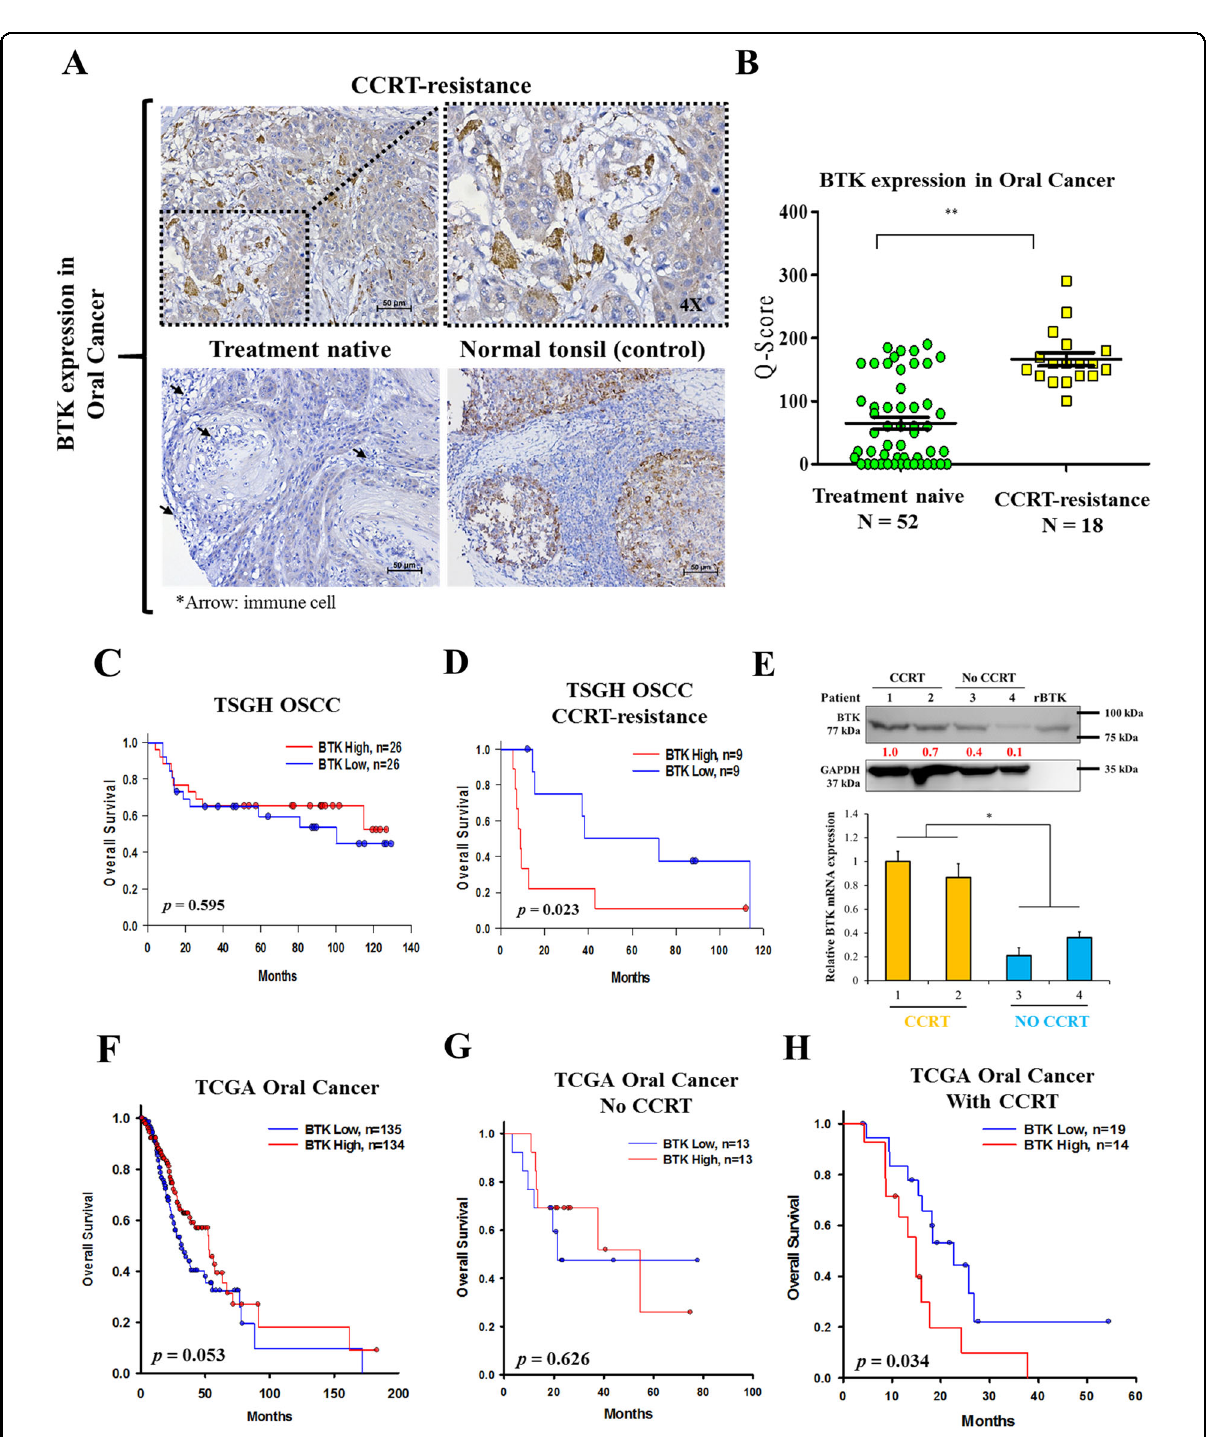
Fig. 1 BTK is aberrantly expressed in human OSCC tissues after additional treatment and in fl uences the survival rate. A IHC staining of BTK expression on OSCC tissues in CCRT-resistant (upper) and treatment-naïve tissue, normal tonsil as a control (bottom). Black arrow indicates the immune cells. B Q-score of BTK expression in TSGH patients with OSCC with treatment-naïve ( n = 52) and CCRT-resistant tissues ( n = 18). C Kaplan – Meier curves showing the effect of low- and high-BTK expression on the overall survival of TSGH patients with OSCC. D Overall survival of TSGH patients with OSCC relapses from CCRT. Median gene expression was used to determine low/high cut-off value. E Graphical representation of BTK expression in OSCC patients ’ samples with or without additional RT/chemotherapy (top image: BTK expression in patient tissue, bottom image: BTK mRNA expression in patient tissue; rBTK: BTK recombinant protein standard, 77kDa). F Kaplan – Meier curves showing the effect of low- and high-BTK expression on the overall survival of TCGA patients with OSCC ( n = 269). G Overall survival of TCGA patients with OSCC without additional therapy. H Overall survival of TCGA patients with OSCC relapses from CCRT. Median gene expression was used to determine low/high cut-off value. * p <0.05, ** p